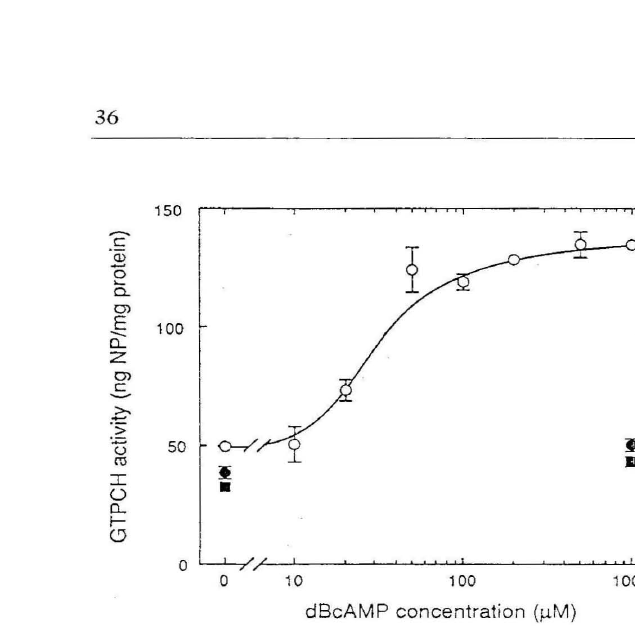
Figure 1. Effects of dibutryl cAMP on the GTP cy c1ohdrolase I activity of pheochromocytoma PC 12 cells.